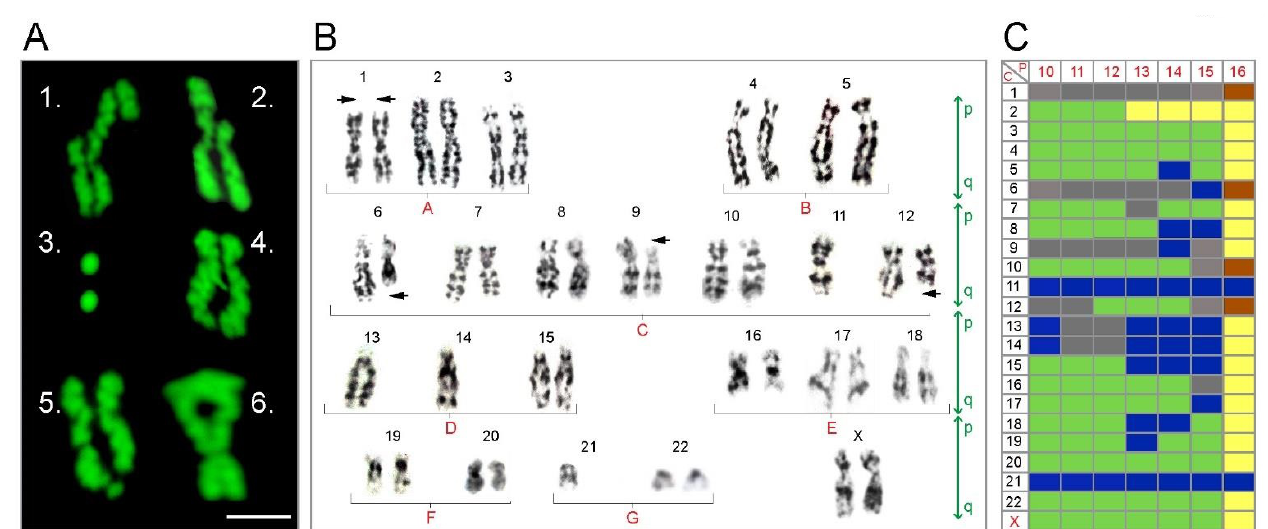
Figure 5. Chromosomal aberrations with passaging in U87MG exposed to ATRA. Representative examples of pseudo- colored chromosomes after Giemsa staining showing various chromosome aberrations in U87MG cells post passage 10–16. Chromosome 6 alignment with chromosome 13 with potential inter-chromatid interchanges ( A1 ), chromosome 3 with chromatid p arm deletion ( A2 ), interstitial deletions ( A3 ), chromosome 12 with chromatid protrusion ( A4 ), chromosome 4 with potential q-arm breakage ( A5 ), chromosome 6 telomeric alignment with chromosome 18 or dicentric chromosome ( A6 ). Representative karyotype spread of Wright stained chromosomes from U87MG passage 10 cells. Monosomy indicated by absence of chromosome. P and q represent short and long chromosomal arms. Chromosomal groups represented by letters A – G, and chromosomes numbered according to standard practice for a female karyotype. Arrows point to deletions (black arrows) ( B ). Illustrative table summarizing chromosomal anomalies arising with passaging U87MG. Passage (P) number shown across the top, chromosome ( C ) number shown along the side of the table. Colors represent chromosomal deletions (grey), stability (green), anomalies (red), polyploidy (yellow) and monosomy (navy blue).